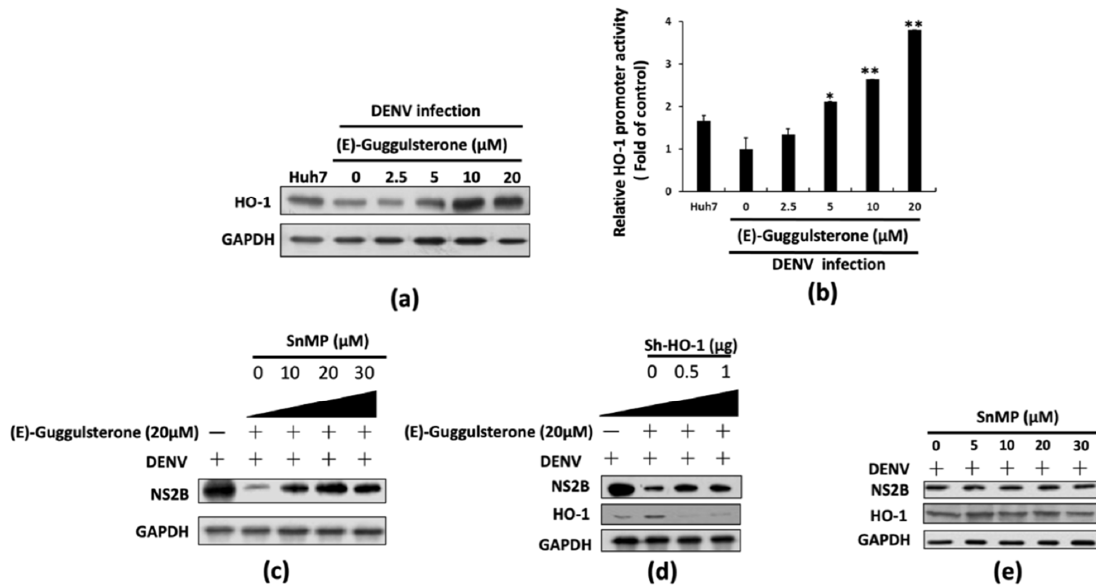
Figure 2. (E)-Guggulsterone inhibits DENV replication through an HO-1 dependent pathway. ( a ) (E)-guggulsterone enhanced HO-1 protein expression in the DENV-infected cells. DENV-infected Huh-7 cells were treated with the indicated concentrations of (E)-guggulsterone for 3 days, and the HO-1 protein levels were analyzed by Western blotting. ( b ) (E)- guggulsterone induced the promoter activity. The HO-1 promoter-reporter plasmid, pHO-1-Luc, was transfected into Huh-7 cells. The plasmid-transfected cells were infected with DENV and treated with the indicated concentrations of (E)- guggulsterone (0–20 μ M) for 3 days. The cell lysates were then subjected to luciferase activity assay. The relative luciferase activity is presented as fold activation compared to 0.1% DMSO-treated cells (designated as “0”), with DENV infection, defined as “1”. ( c , d ) Inhibition of HO-1 activity or silencing of HO-1 expression attenuated the inhibitory effect of (E)- guggulsterone on DENV replication. DENV-infected Huh-7 cells were treated with different concentrations of HO-1 in- hibitor SnMP (10, 20, 30 μ M) or co-transfected with different concentrations of plasmid encoding HO-1 shRNA, pCMV- sh-HO-1, (0.5 and 1 μ g) in the absence or presence of (E)-guggulsterone (20 μ M) for 3 days. ( e ) SnMP shows no significant effect on DENV replication and HO-1 expression. DENV-infected Huh-7 cells were treated with different concentrations of SnMP (10, 20, and 30 μ M) for 3 days. The DENV and HO-1 protein synthesis was assessed using Western blotting. The treatment with 0.1% DMSO was defined as “0”. The error bars for treatment denote the mean ± SD of three independent experiments ( n = 3). * p < 0.05; ** p < 0.01.